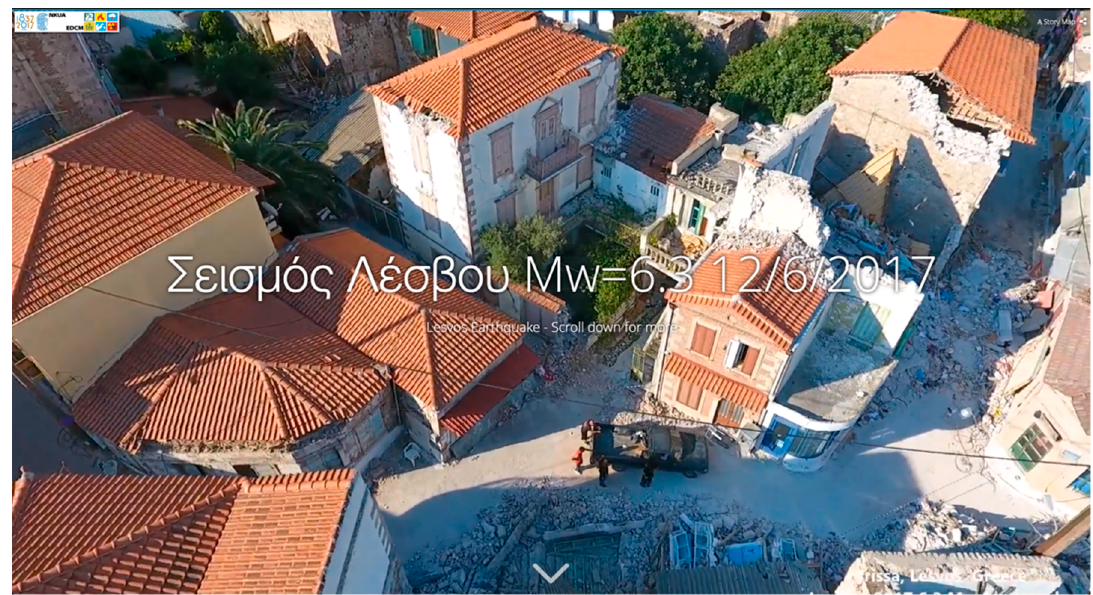
Figure 8. Story map providing information about the Lesvos earthquake on 12 June 2017, Mw = 6.3 (https://tinyurl.com/y5c93nkt).